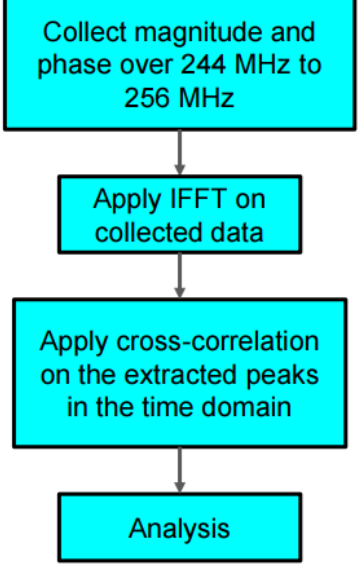
Figure 2. Flow chart of the proposed measurement system.